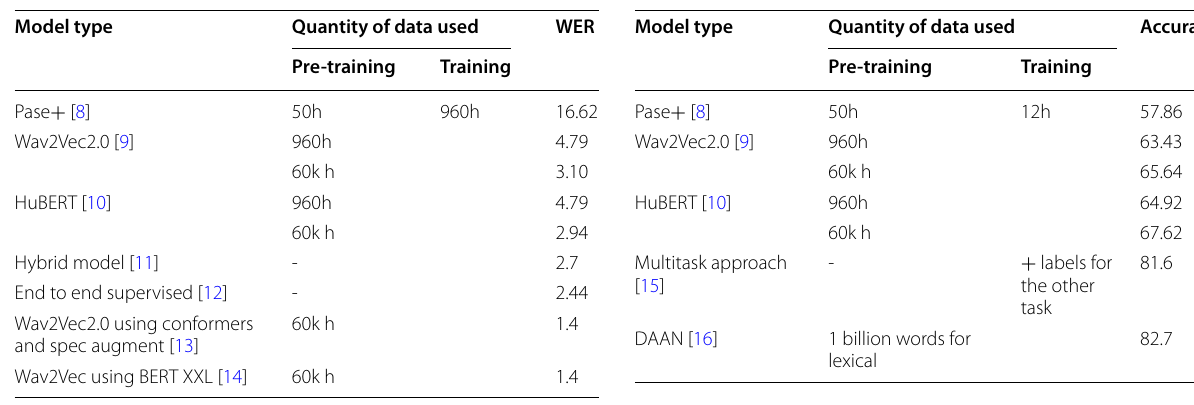
Table 1 SOTA results over test-clean set from LibriSpeech and quantity of data used. Some self-supervised results are provided from [7]